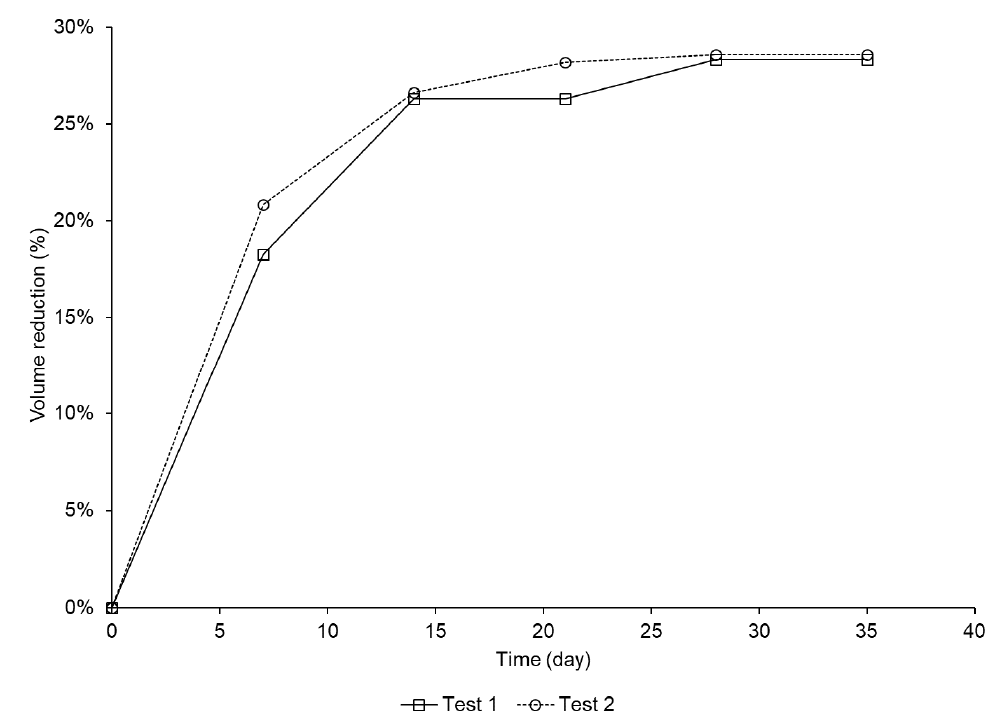
Figure 6. Volume reduction in Test 1 and Test 2.